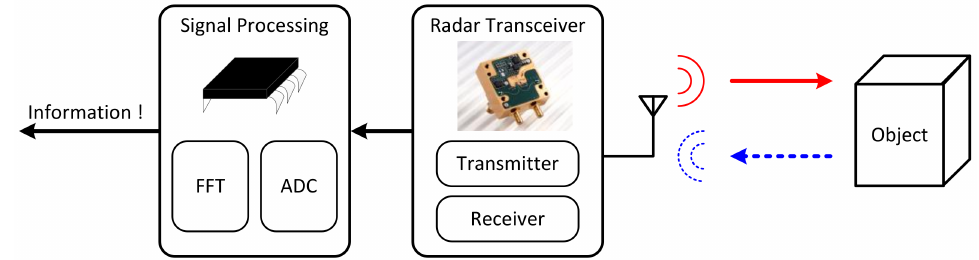
Figure 1. Conceptual diagram explaining the general operation of the radar